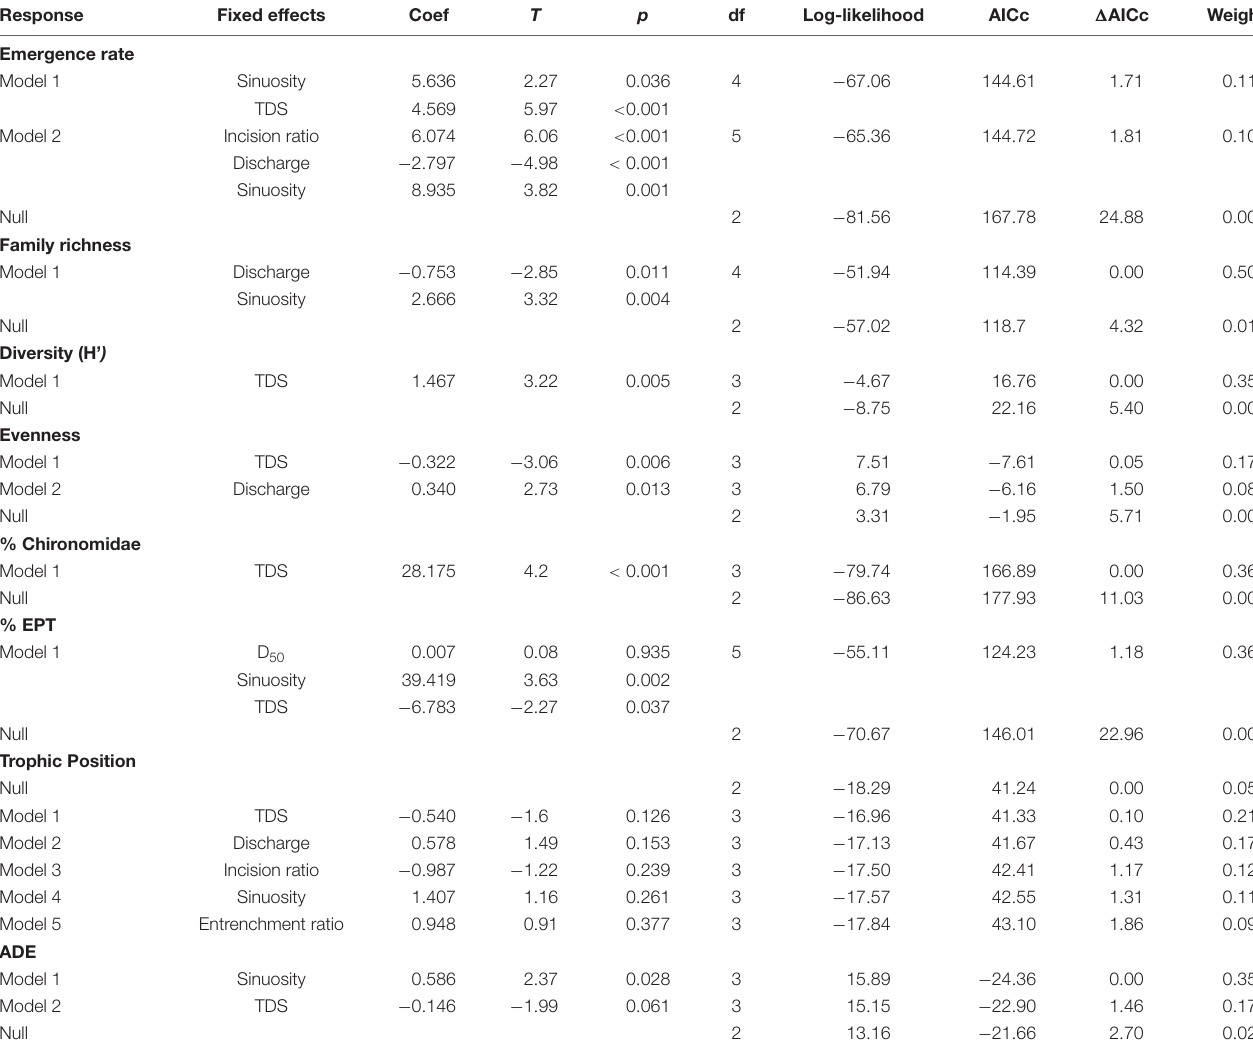
TABLE 2 | Model results with AICc < 2 (excluding those with uninformative parameters) from general (normal distribution for evenness, % EPT, % Chironomidae, TP, and ADE) and generalized (lognormal distribution for emergence rate [no. m − 2 day − 1 ] and family richness; gamma for diversity [ H ’]) linear models with hydrogeomorphic characteristics as predictors of emergent aquatic insect flux